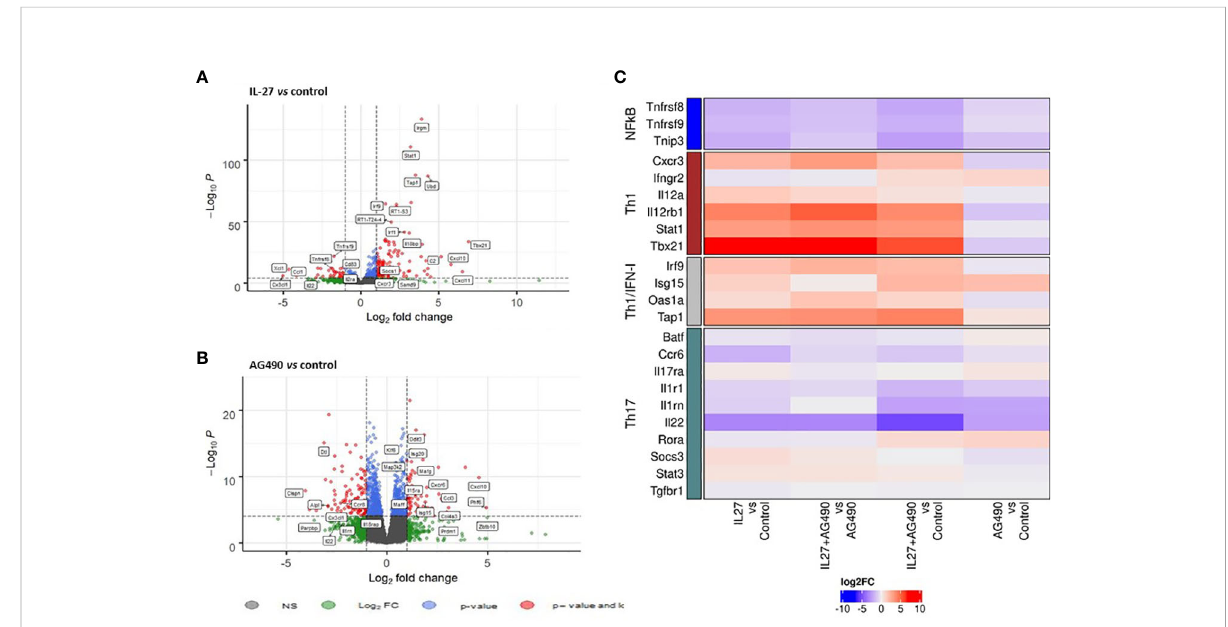
FIGURE 4 IL-27 modulatory effect is associated with STAT1/STAT3 balance restoration. Naïve T cells that had been coculture with splenic cDC2s and coated-anti-CD3, in the presence or not of mrIL-27 (5 ng/mL), AG490 (10 µg/mL) or both for 24 h were sorted. RNA was isolated and global gene expression was determined by RNA-seq. (A) volcano plot represents IL-27 condition compared to medium control and (B) AG490 condition compared to medium control. (A, B) The data for all genes are represented by log2 (fold change) vs log10 of adjusted p-value. (C) A heatmap of fold change (log2) for genes differentially expressed between conditions is shown. Values represent results from of 5 rats aged of 4- 5 months per